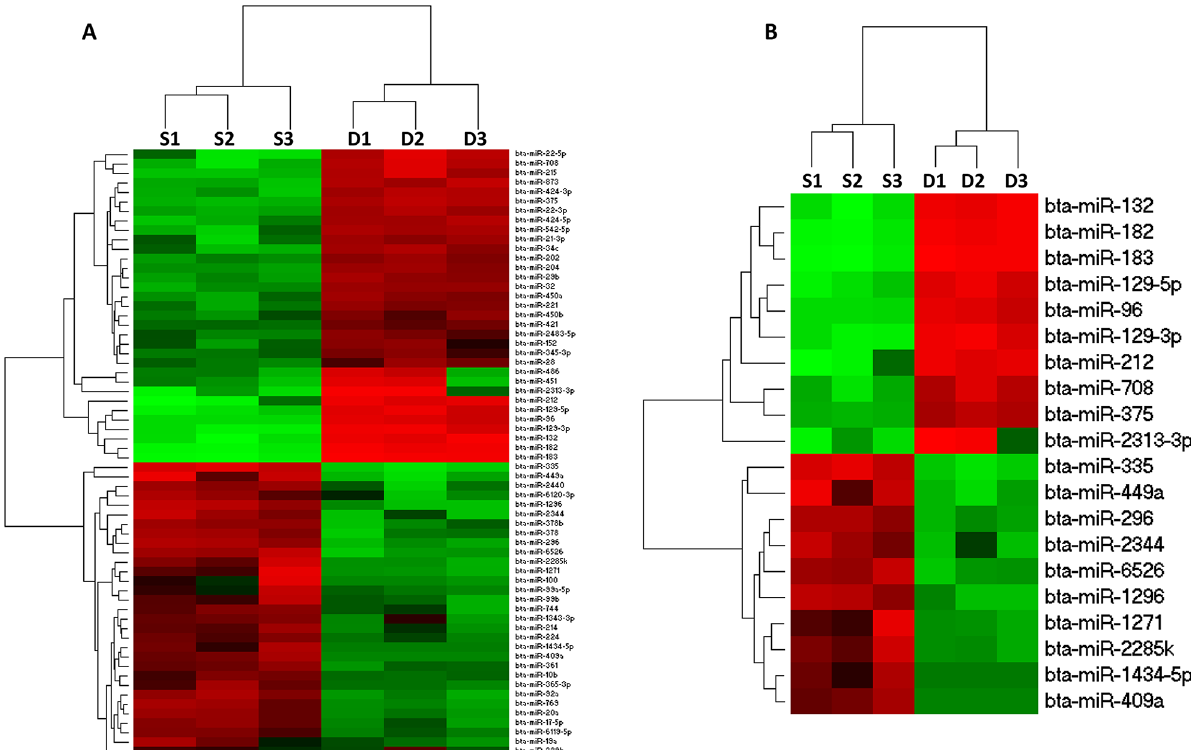
Fig 2. Hierarchical clustering of differentially expressed miRNAs in granulosa cells of preovulatory dominant and subordinate follicles. Heat map of all differentially expressed miRNAs in preovulatory dominant follicles ( A ) and 20 top miRNAs differentially expressed in preovulatory dominant follicles ( B ). Red and green blocks represent up and down regulated miRNAs, respectively. Legend: S1-S3 subordinate follicle triplicates and D1-D3 preovulatory dominant follicle triplicates.